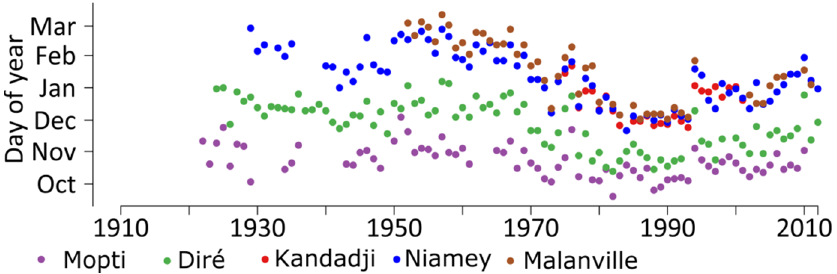
Figure 7. Shift in day of AMAX for the stations influenced by the Inner Niger Delta for the Guinean flood.